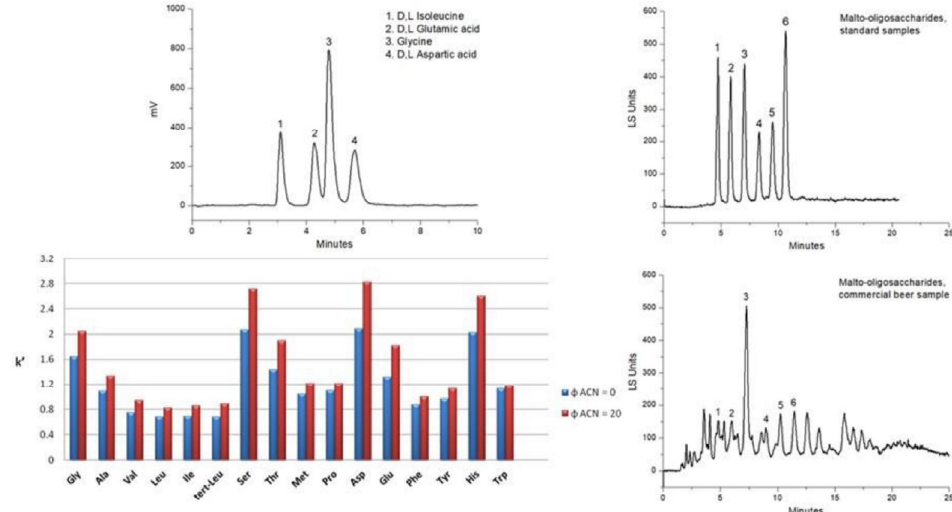
Figure 3. ( Top left ) Separation of isoleucine, glutamic acid, glycine, and aspartic acid on VSG_HD- 1-Photo-Cys-column (5 μ m, 150 × 4.6 mm ID). ( Bottom left ) Retention factor of other amino acids. Blue bar, RP condition; red bar, HILIC condition. ( Top and bottom right ) Separation of malto-oli- gosaccharides (standard samples, top; in a commercial beer sample, bottom). Reproduced with per- mission [66] .